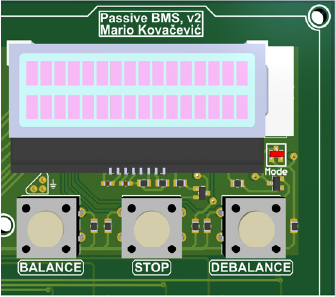
Figure 4. User interface related components.